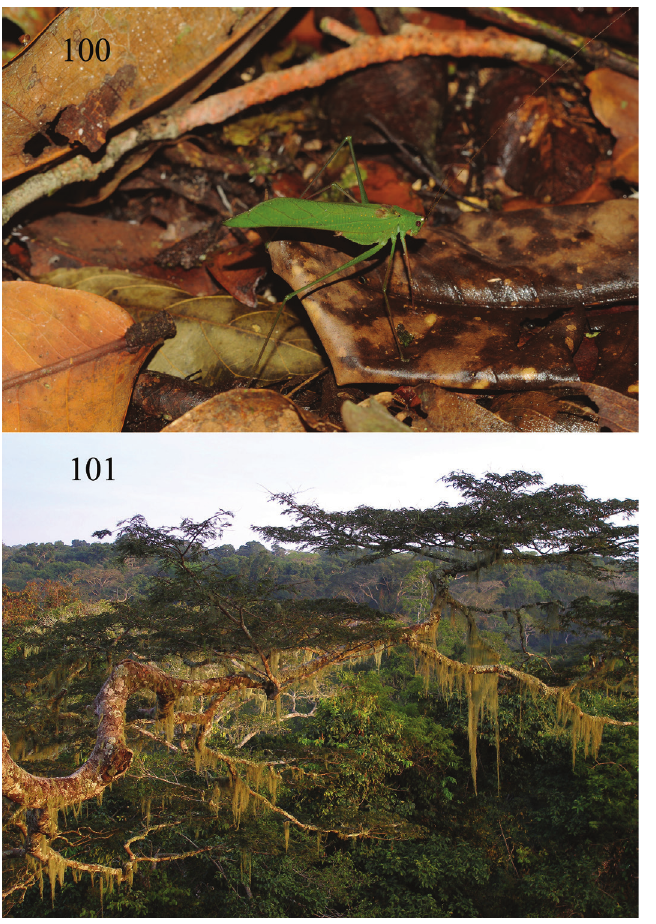
Figs 100–101. 100. Specimen of T. annoyeri sp. n. photographed in the field on the litter of the Dzanga-N’Doki National Park. 101. Can- opy of the forest of the Dzanga-N’Doki National Park, where some Tetraconcha were collected in 2008-2012 (Photo by P. Annoyer).